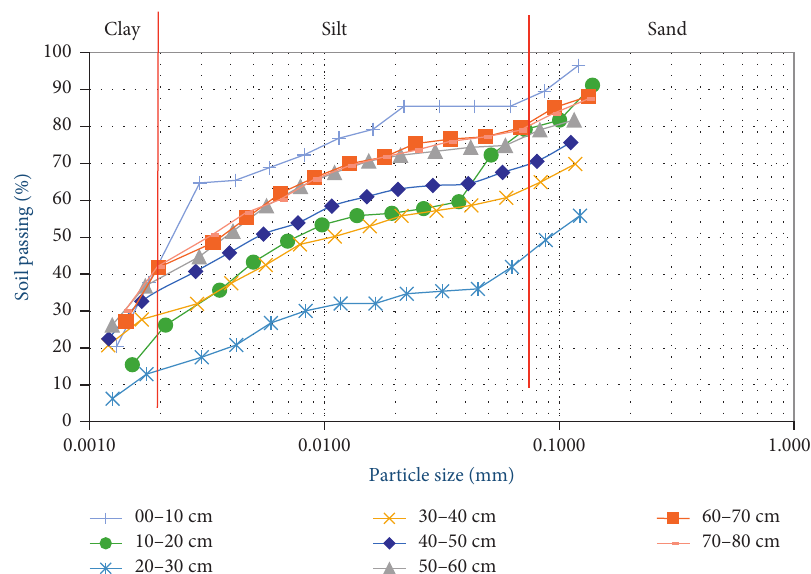
Figure 5: Hydrometer analysis grading curves of the sample from location